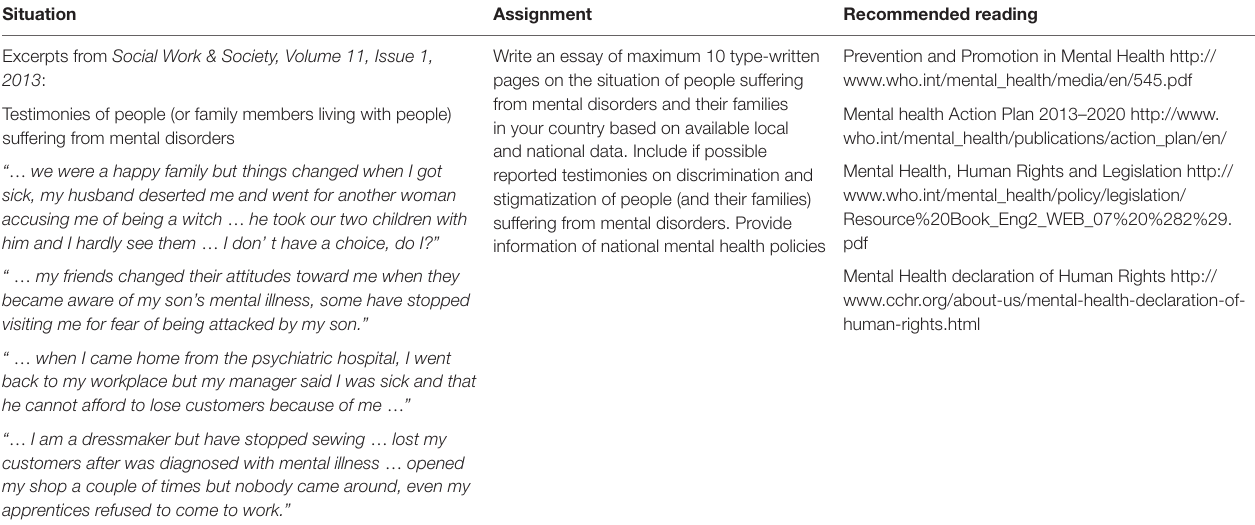
table 3 | Example of a case study.